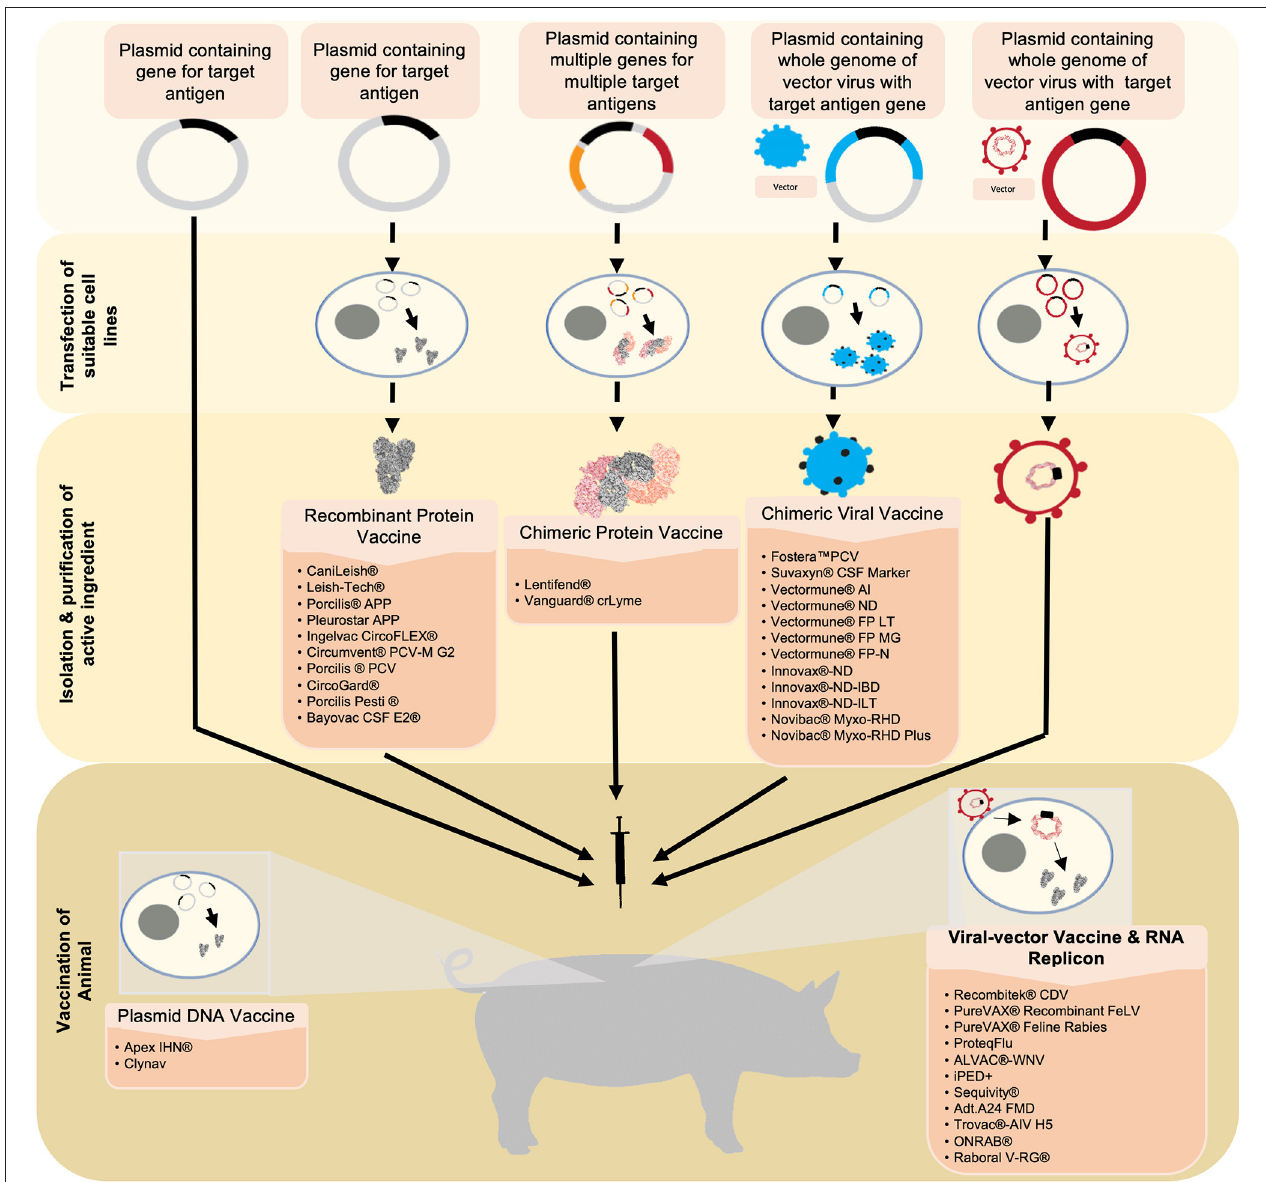
FIGURE 1 | Six novel vaccine technologies discussed in this review are simplified and summarized starting from the generation and production of antigens to the vaccination. Beginning with plasmid-DNA vaccines, the target antigen is inserted into a plasmid. This serves as the active ingredient that will be used to vaccinate the animal. Upon vaccination, the plasmid-DNA vaccine carrying the DNA encoding for the target antigen is translated into the desired protein in the vaccine recipient’s cells. The antigen is then expressed from the cell, consequently eliciting an immune response. Recombinant protein vaccines and chimeric protein vaccines utilize a similar technology. However, suitable cell-lines are transfected with the plasmid in which the antigen(s) is/are expressed. The antigen(s) is/are then harvested, purified, and formulated into the vaccine. Chimeric viral vaccines utilize a plasmid containing the whole genome of a virus that will be used as a vector in addition to the target gene for the desired antigen. This plasmid is then used to transfect a suitable cell-line in which a whole virus expressing the integrated antigen is produced. This virus is harvested and purified, and formulated into a vaccine. Viral vectors utilize a virus that has been engineered to express the gene of interest. The virus is formulated into a vaccine and will release the recombinant genes into the host cells. Similar to a plasmid-DNA vaccine, the genes will be transcribed into the target antigen which will then be expressed and elicit an immune response. RNA replicon vaccines utilize a RNA segment that encodes the desired antigens encapsulated in a vesicle carrier. Once in the host’s cell, the RNA is directly translated, resulting in the expression of the target